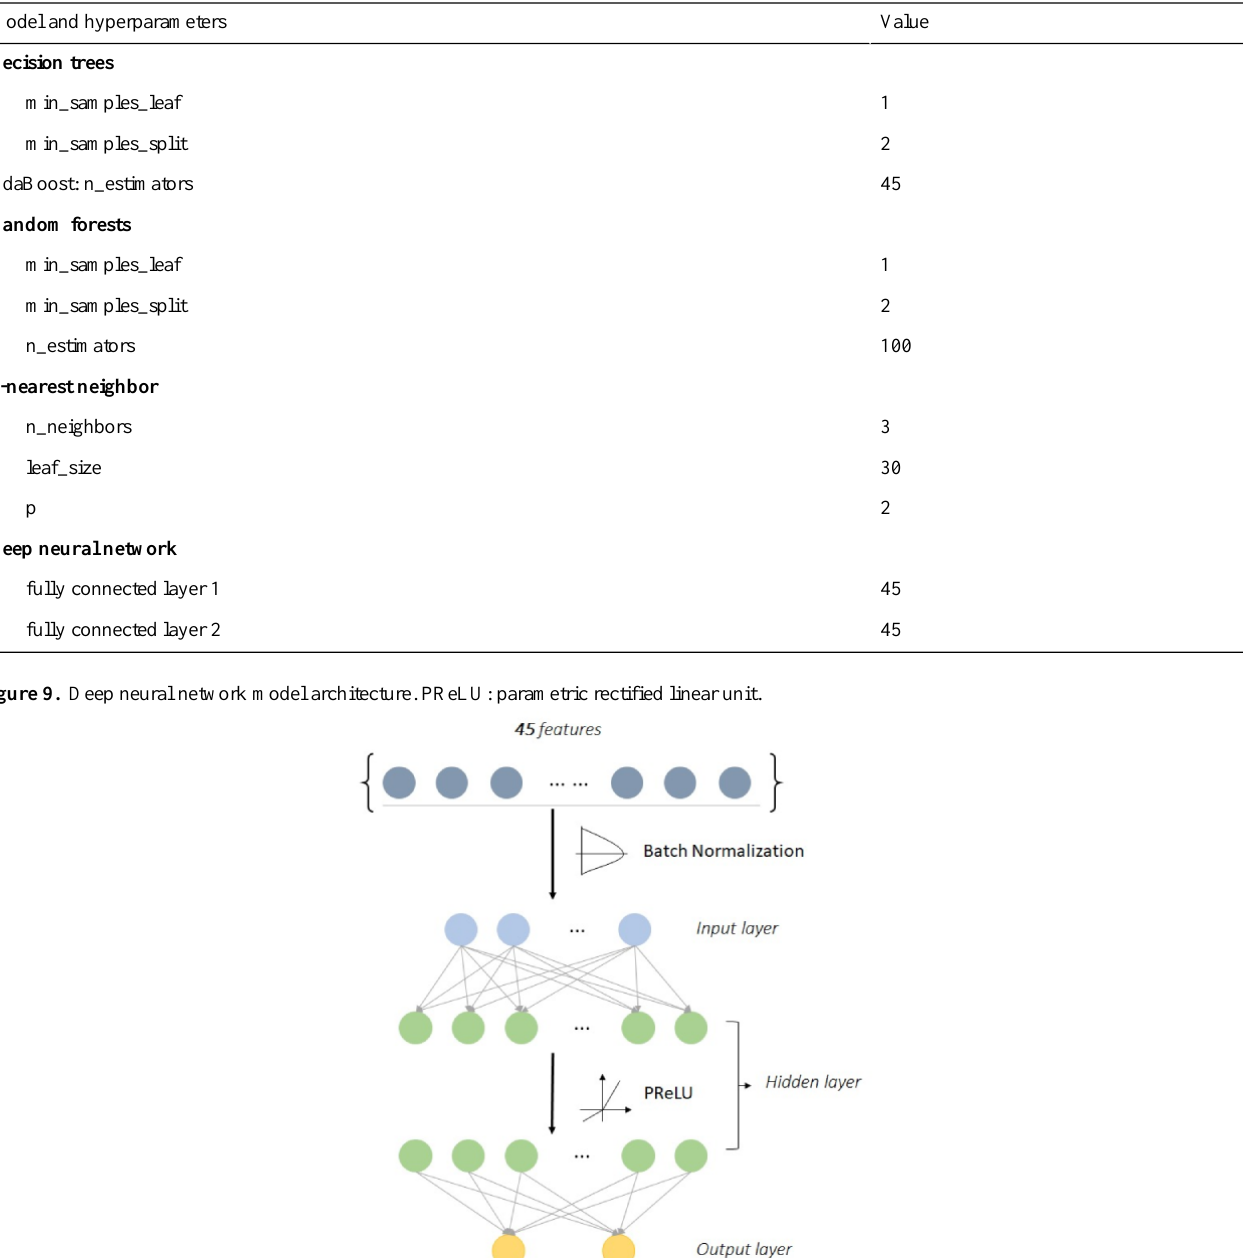
Table 1. Hyperparameters of the machine-learning and deep-learning models.